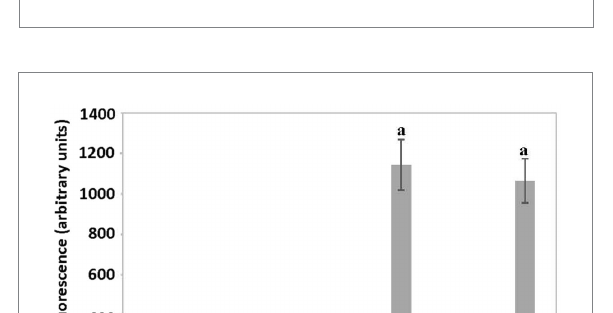
FIGURE 3 srlA promoter activity in wt and ∆ srlA host backgrounds. Transcription activity detected from reporter vector pOT1, pEB57 (127 bp region upstream of srlA in same orientation as gfp ) and pEB58 (127 bp region upstream of srlA in opposite orientation as gfp ) in RmP110 (wt) and NB1854 ( ∆ srlA ) host strains. GFP activity reported as mean ± sd, n = 3. Letters indicate whether means are significantly different ( p < 0.01, ANOVA and Tukey HSD).